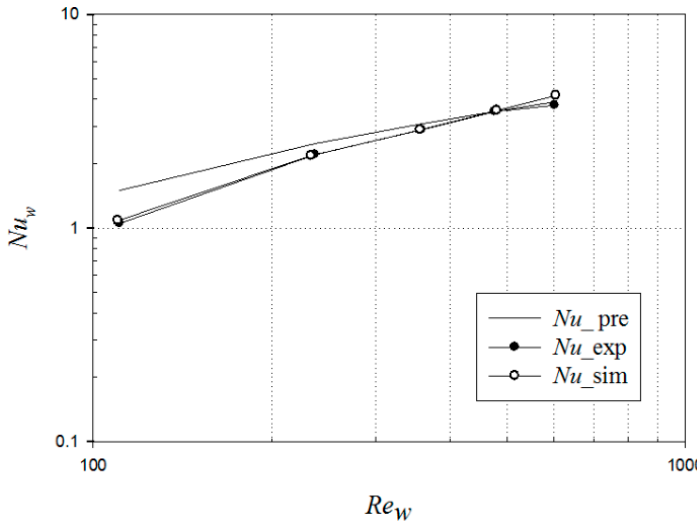
Figure 5. Nusselt number vs. Reynolds number of the plain plate-fin heat sink obtained by prediction, experimental measurement, and numerical simulation.